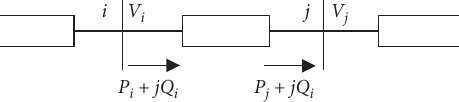
Figure 5: The node branch model.